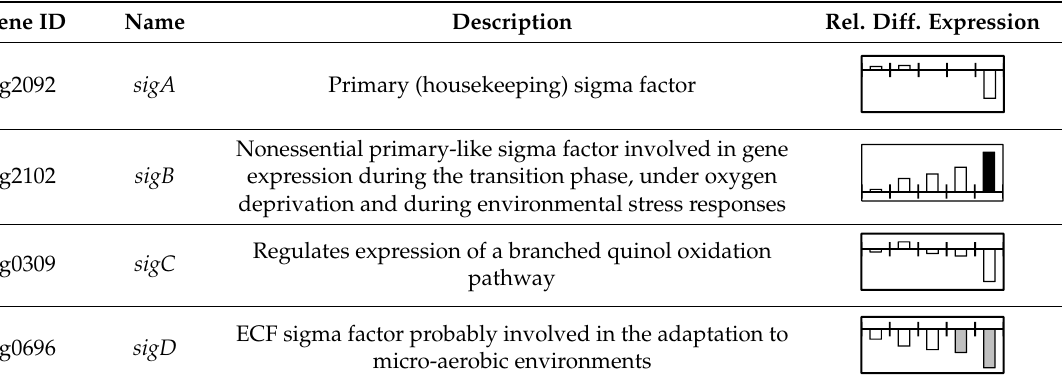
Table A2. Relative differential expression of sigma factors. Description based on literature [98,103]. Column graphs represent log 2 -fold changes of enhanced (black) and reduced (grey) expression. Open columns are values outside the significance constraints ( m -value > 1.50, < − 1.50 and a -value > 1.00). From left to right aerobiosis ( ② ), microaerobiosis ( ③ , ④ , ⑤ ) and anaerobiosis ( ⑥ ) versus the aerobic reference ( ① ; Figure 1A). Scaling of these graphs is variable.